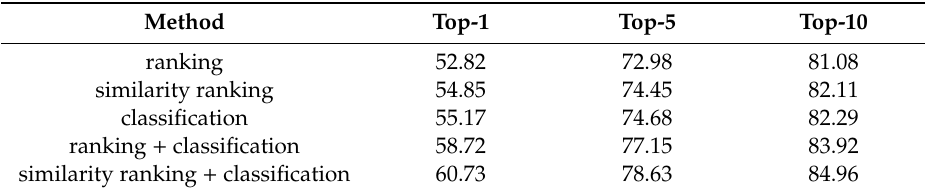
Table 5. Joint loss function e ff ectiveness experimental